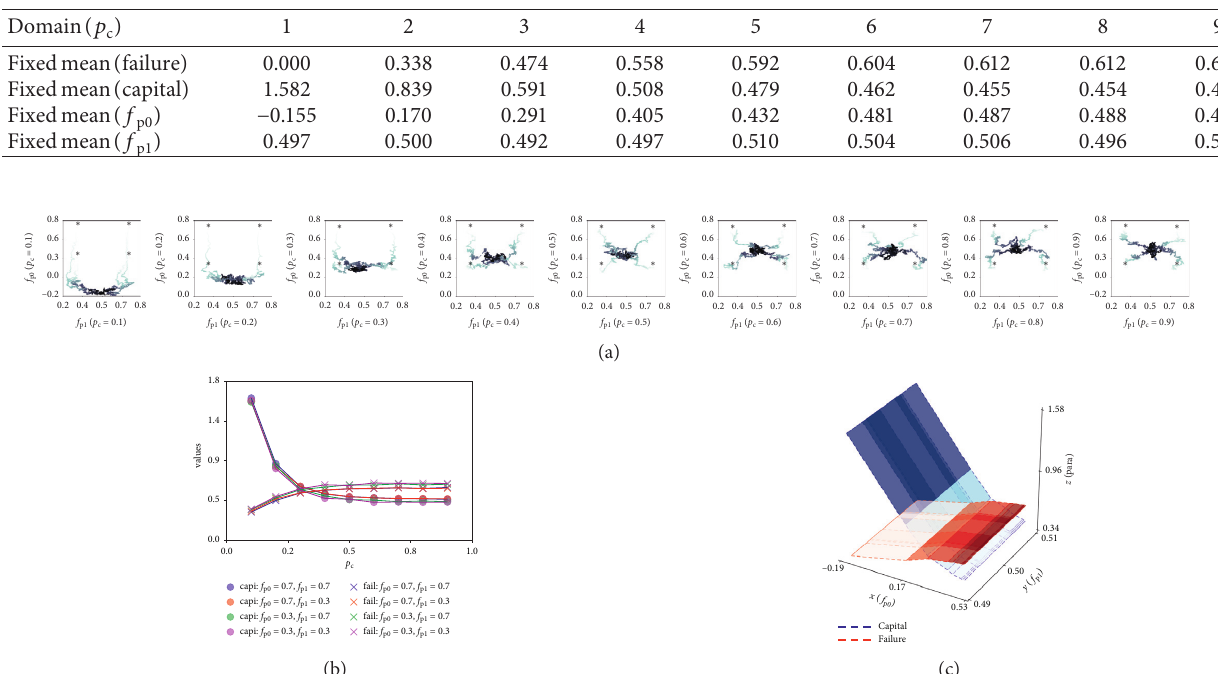
Table 2: Numerical result of the failure controlled by p